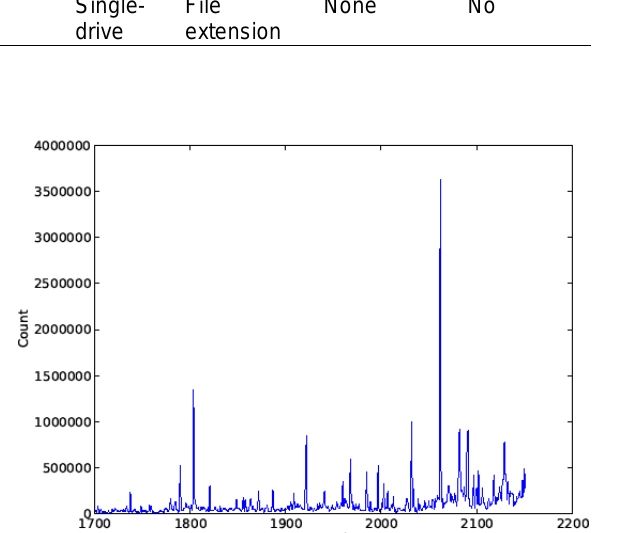
Figure 2. Portion of histogram of creation times per week in our